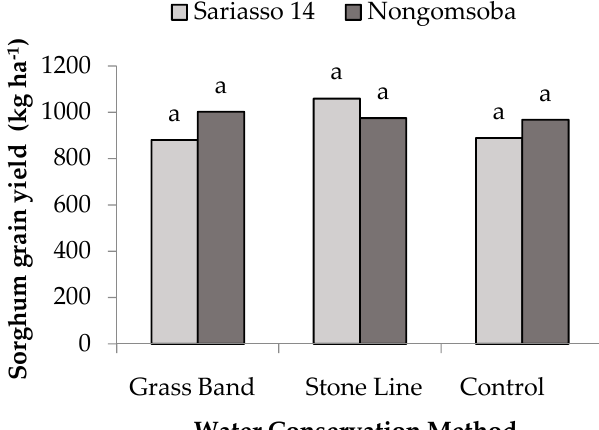
Figure 5. Sorghum grain yield of the two sorghum varieties as affected by water conservation methods at Saria Research Station, Burkina Faso, in 2008. Columns with the same letter are not significantly different at p ≤ 0.05.